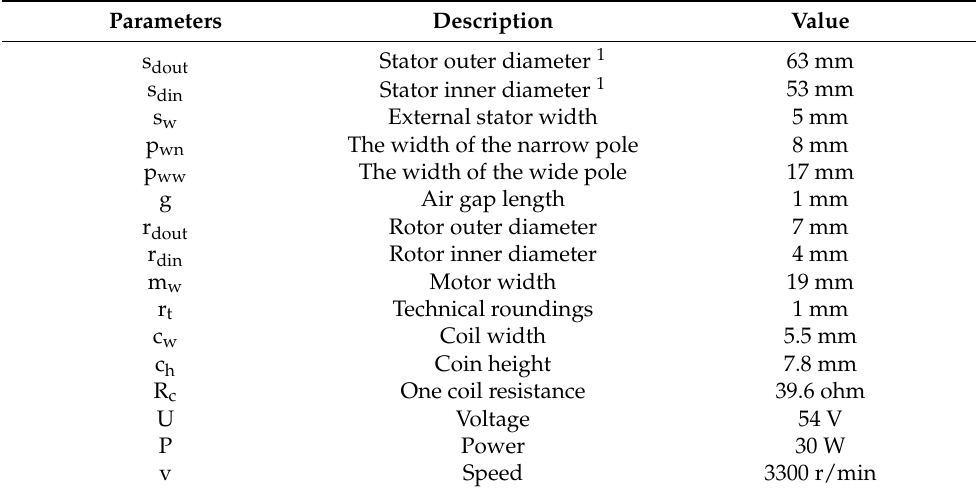
Figure 9. The idea of COMSOL parts and construction of motors: ( a ) diagrams and ( b ) model B3.b. The basic model is the model marked as B3.b3 (Figure 9), for which dimensions were adopted by following the dimensions of the real motor from Figure 1. For the remaining models, analogous dimensions were adopted. For example, motors with a circular stator have a stator radius corresponding to a wheel into which can be inscribed a hexagon corresponding to the reference motor. The values of physical dimensions (for example, stator outer/inner diameters, air gap length, rotor outer/inner diameters and motor width, and coil width/height) and electric parameters (for example, voltage and power) of the reference motor are reported in Table 1. The comparison of geometric dimensions for two different models is shown in Figure 10. Table 1. Basic parameters of reference device.